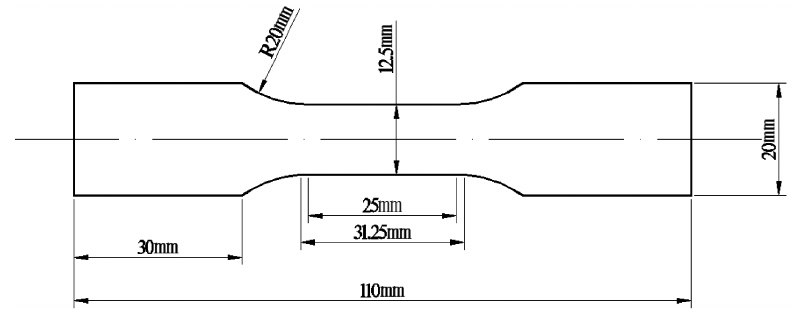
Fig. 1: Specimen for tensile